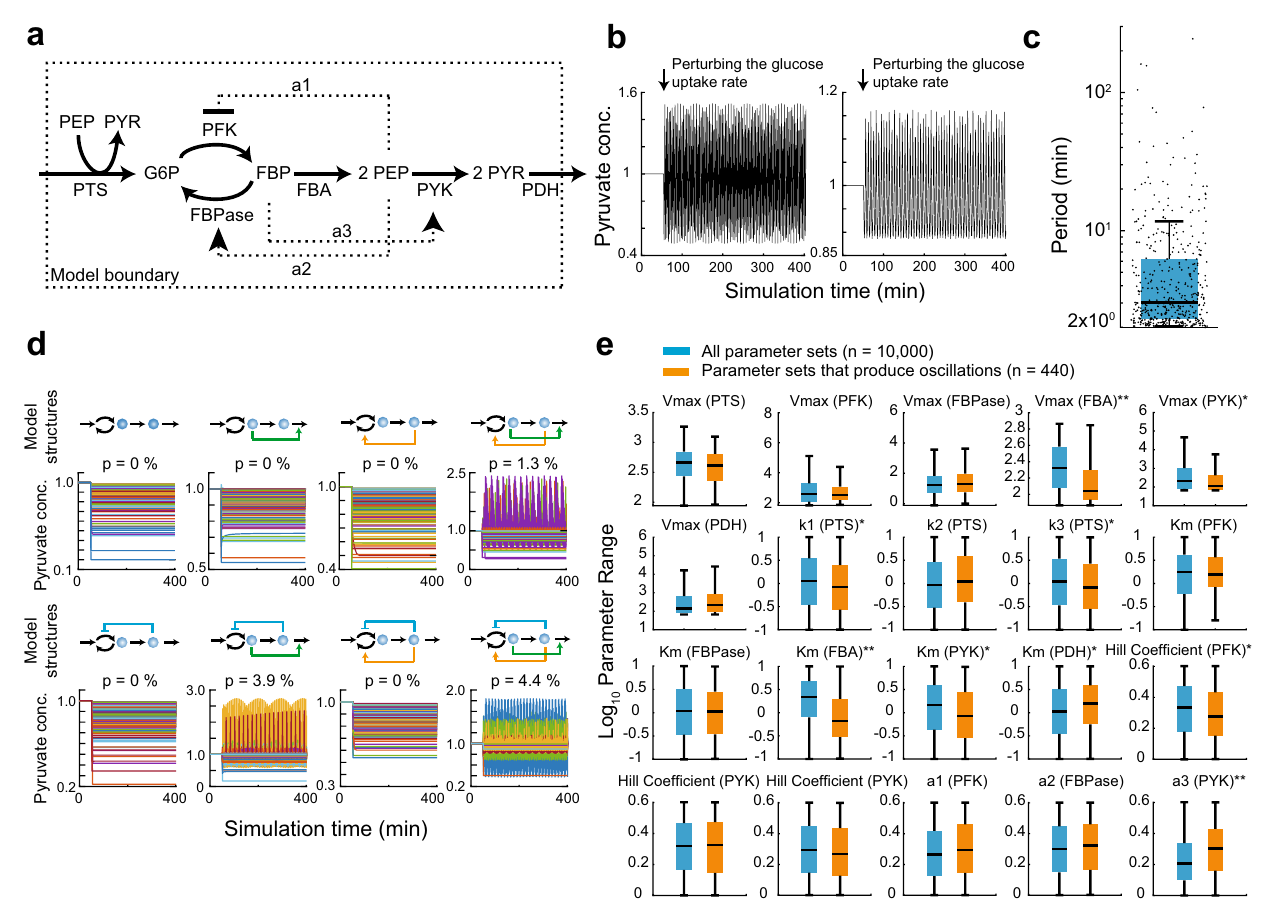
Fig. 1 | A kinetic model of glycolysis predicts periodic oscillations. a Structure and stoichiometry of a simpli fi ed model of glycolysis. The outer dotted line is the model boundary. Solid arrows are reactions and dotted arrows are allosteric interactions of metabolites with enzymes. G6P: glucose-6-phosphate, FBP: fruc- tose-1,6-bisphosphate, PEP: phosphoenolpyruvate, PYR: pyruvate, PFK: phospho- fructokinase, FBPase: fructose-1,6-bisphosphatase, PYK: pyruvate kinase, FBA: fructose-bisphosphate aldolase, PTS: phosphotransferase system, PDH: pyruvate dehydrogenase. b Two examples of simulated pyruvate concentrations with two differentparametersetsthatproducepyruvateoscillations.Themodelwasinitially at steady state and at t=50min the glucose uptake rate (Vmax of PTS) was decreased by 5%. c Boxplot showing the distribution of the periods of 440 simula- tions with oscillating pyruvate levels. Each black dot corresponds to a parameter set.Theblacksolidlinewithintheblueboxdenotesthemedianofthedistribution. Boxes contain 50% and whiskers 99% of the simulated parameter values. d Ensemble modelling approach to test the in fl uence of different feedback